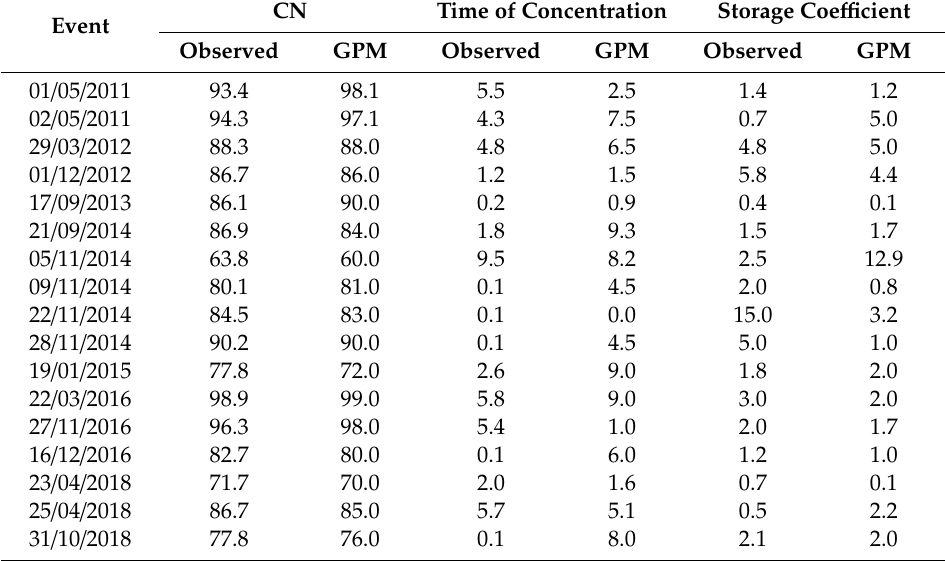
Table 5. Calibrated parameters of the hydrological